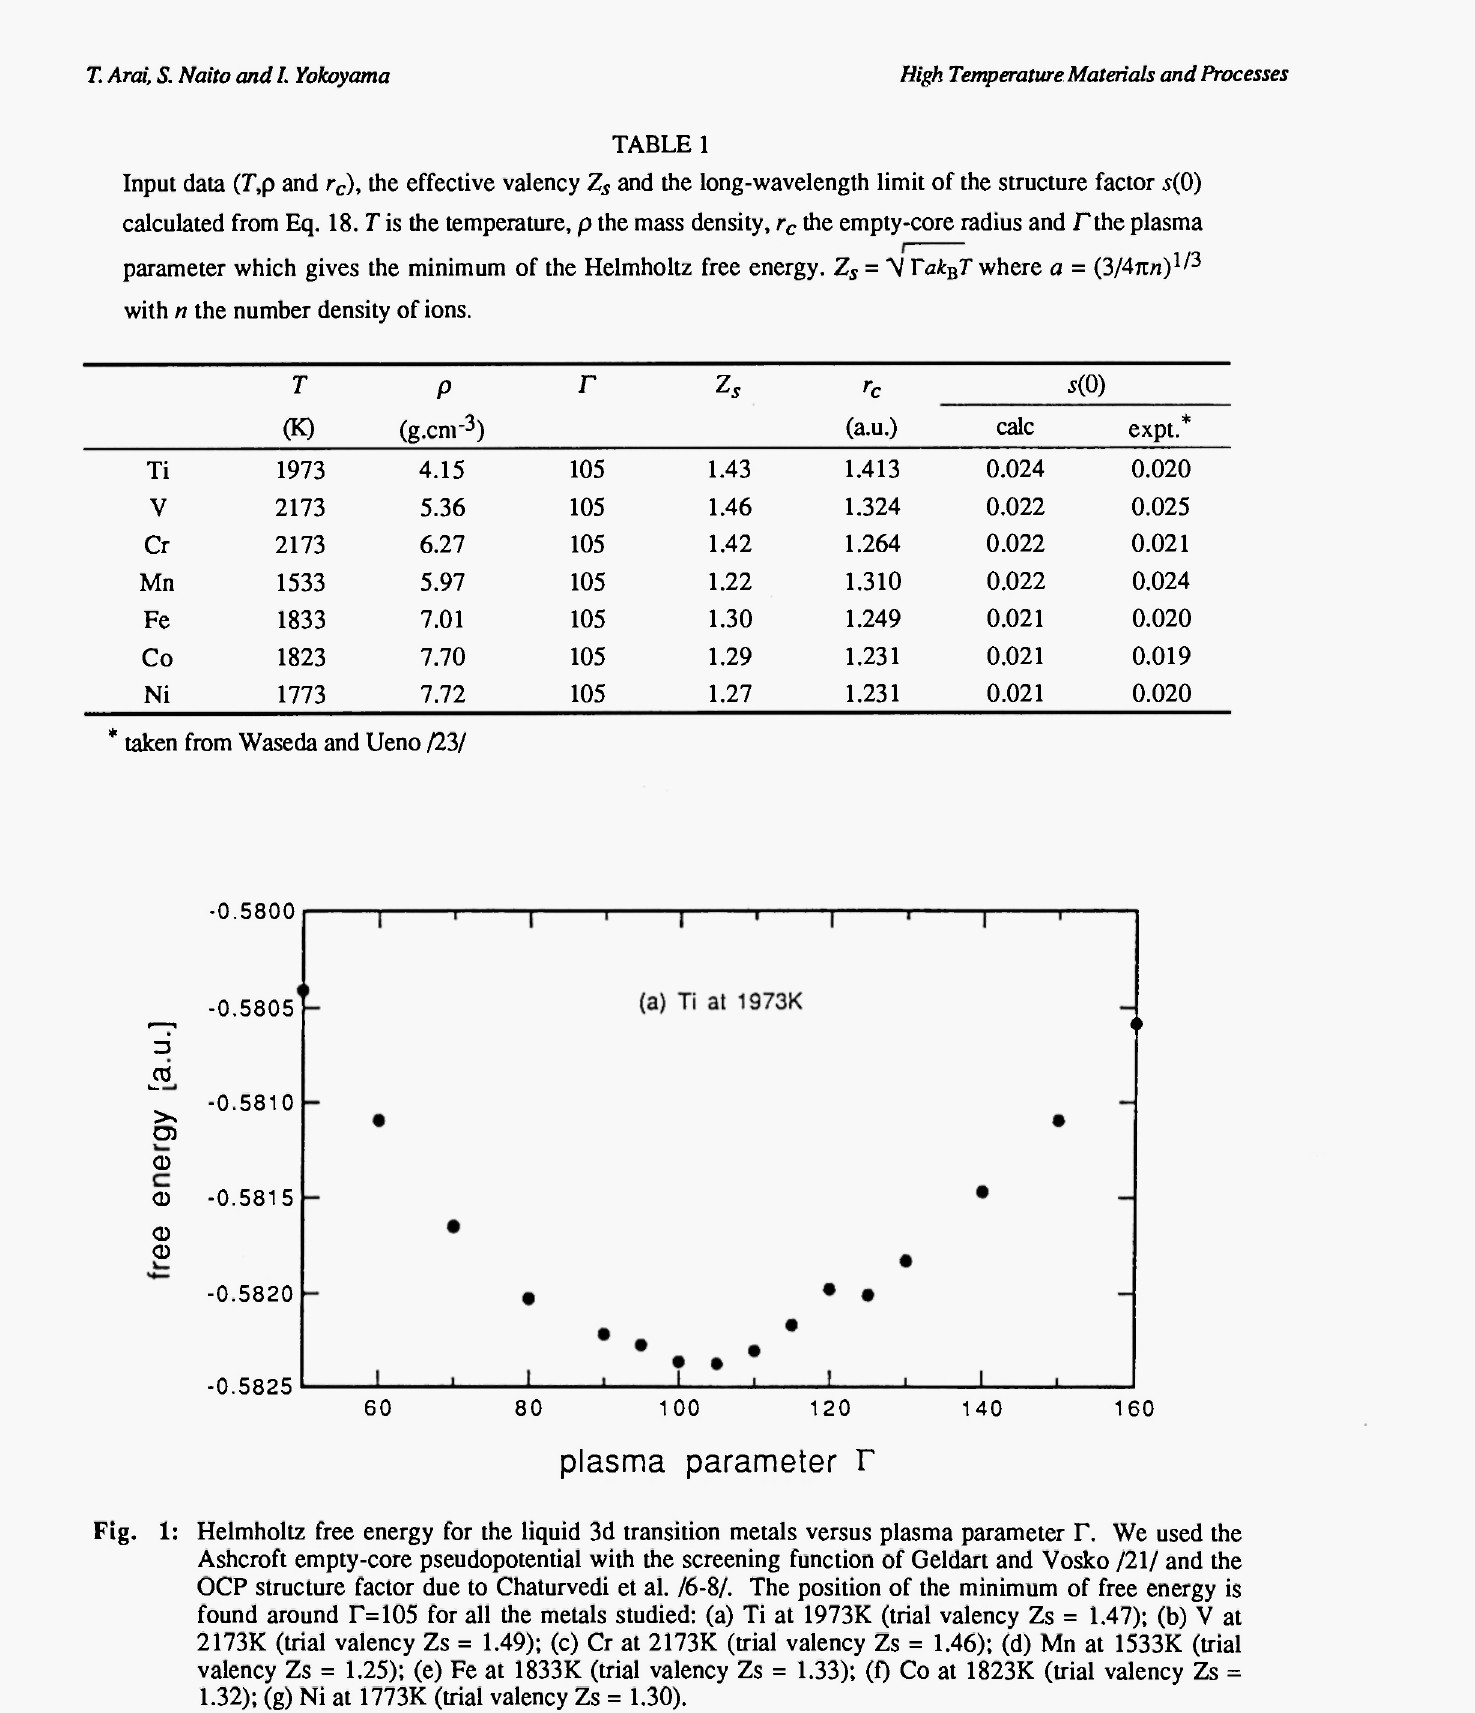
Input data (Τ, ρ and r c ), the effective valency Z s and the long-wavelength limit of the structure factor s(0) calculated from Eq. 18. Τ is the temperature, ρ the mass density, r c the empty-core radius and Γ the plasma parameter which gives the minimum of the Helmholtz free energy. Z s = "V Tak^T where a = (3/Λπη) 1 ' 2 with η the number density of ions.